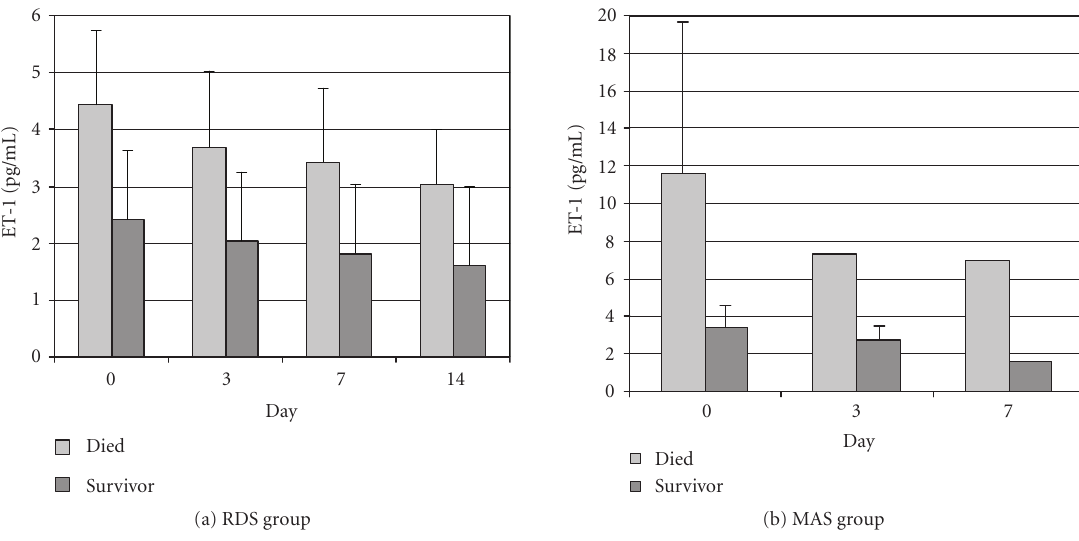
Figure 4: ET-1 concentrations in the newborns who died were 4 . 44 ± 1 . 26pg/mL in RDS and 11 . 60 ± 8 . 97pg/mL in MAS groups ( P < . 05) and in those who survived were 2 . 42 ± 1 . 19pg/mL in RDS and 3 . 41 ± 1 . 31pg/mL ( P < . 05) at the sixth hour of life. ET-1 concentrations in the newborns who died were 3 . 70 ± 1 . 31pg/mL in RDS and 7 . 30 ± 0 . 00pg/mL in MAS group ( P < . 05) and in those who survived were 2 . 04 ± 1 . 20pg/mL in RDS and 2 . 77 ± 0 . 73pg/mL ( P < . 05) at the third day of life. ET-1 concentrations in the newborns who died were 3 . 42 ± 1 . 27pg/mL in RDS and 7 . 00 ± 0 . 00pg/mL in MAS group ( P < . 05) and in those who survived were 1 . 82 ± 1 . 15pg/mL in RDS and 1 . 60 ± 0 . 00pg/mL ( P < . 05) at the seventh day of life. ET-1 concentrations in the newborns who died were 3 . 03 ± 0 . 95pg/mL and in those who survived were 1 . 60 ± 1 . 35pg/mL in RDS ( P < . 05) at the 14th day of